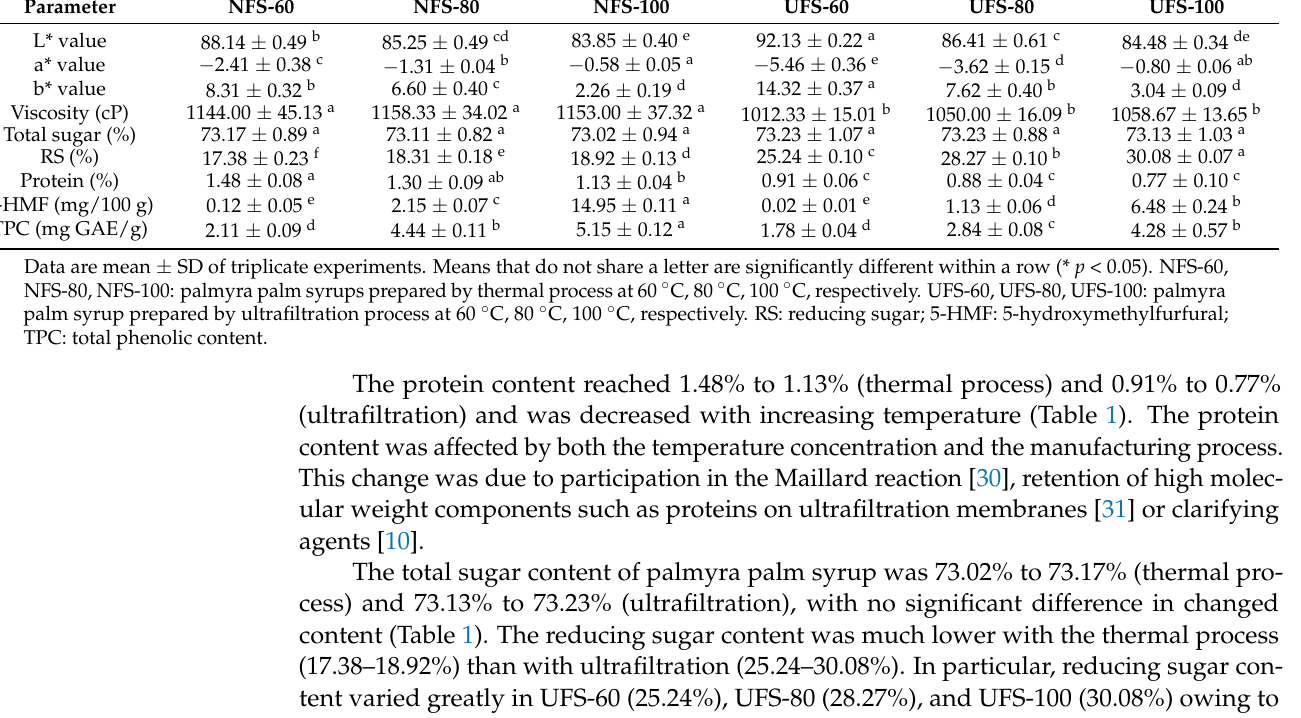
Table 1. Physicochemical characteristics of palmyra palm syrups prepared by thermal and ultrafiltration processes.